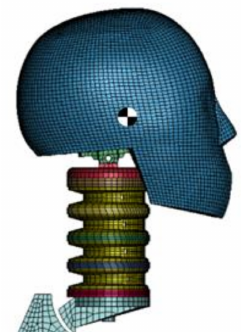
Figure 3. Hybrid III head-neck model with marked center of